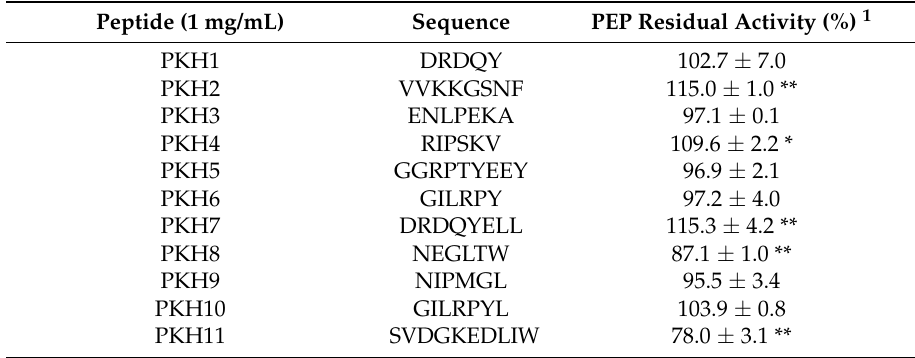
Table 2. Effects of peptides isolated from proteinase K lactoferrin hydrolysate (LFH) on prolyl endopeptidase (PEP) activity.